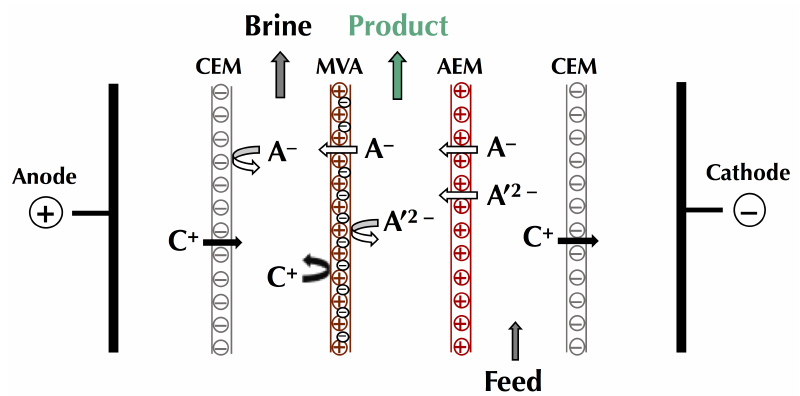
Figure 17. Principle of selectrodialysis. CEM: cation-exchange membrane; AEM: anion-exchange membrane; MVA: monovalent selective anion exchange membrane; A − , A’ 2 − : anions; C + :